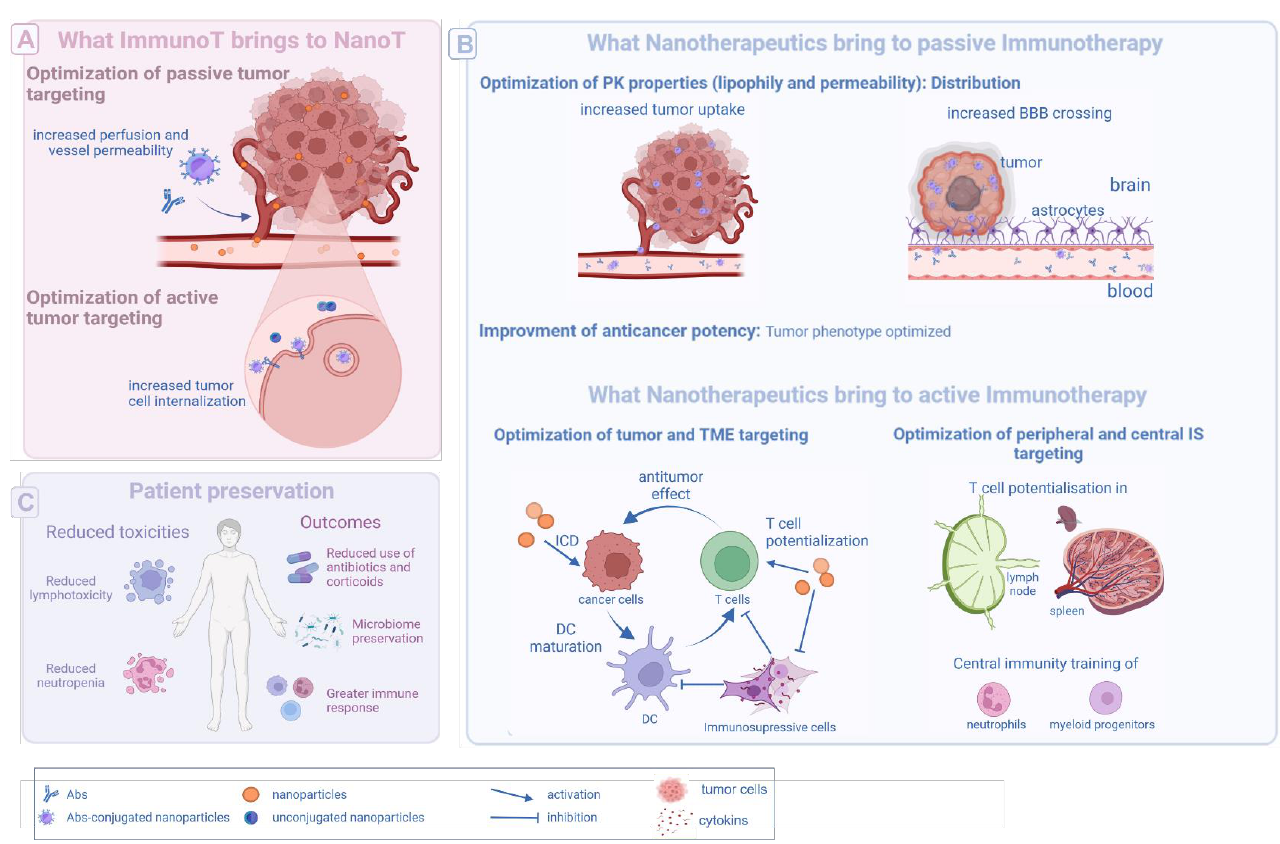
Figure 3. Schematization of the most relevant benefits nanotherapeutics and immunotherapies can get from being combined . Passive immunotherapies (e.g., antibodies) can optimize nanoparticle in- tratumoral accumulation and internalization ( A ). Nanotherapeutics can optimize passive immuno- therapy distributions and modify the tumor phenotype for a better treatment efficacy (B). Nano- therapeutics can also optimize active immunotherapy efficacy by targeting the tumor cells, the TME (i.e., T cells or immunosuppressive cells such as MDSCs, Treg, tumor-associated macrophages) or the peripheral/central immune system ( B ). Together, the combination of nanotherapeutics with im- munotherapies can protect the patient from poor efficacy, drug toxicity, and associated premedica- tion ( C ). DC= dendritic cell, ICD = immunogenic cell death, IL = interleukin, ImmunoT = immuno- therapy, IS = immune system, PK = pharmacokinetics, NanoT = nanotherapeutics, T cell = lympho- cyte T, TME = tumor microenvironment, Treg = regulatory T cell, MDSCs = myeloid-derived sup- pressor cell.